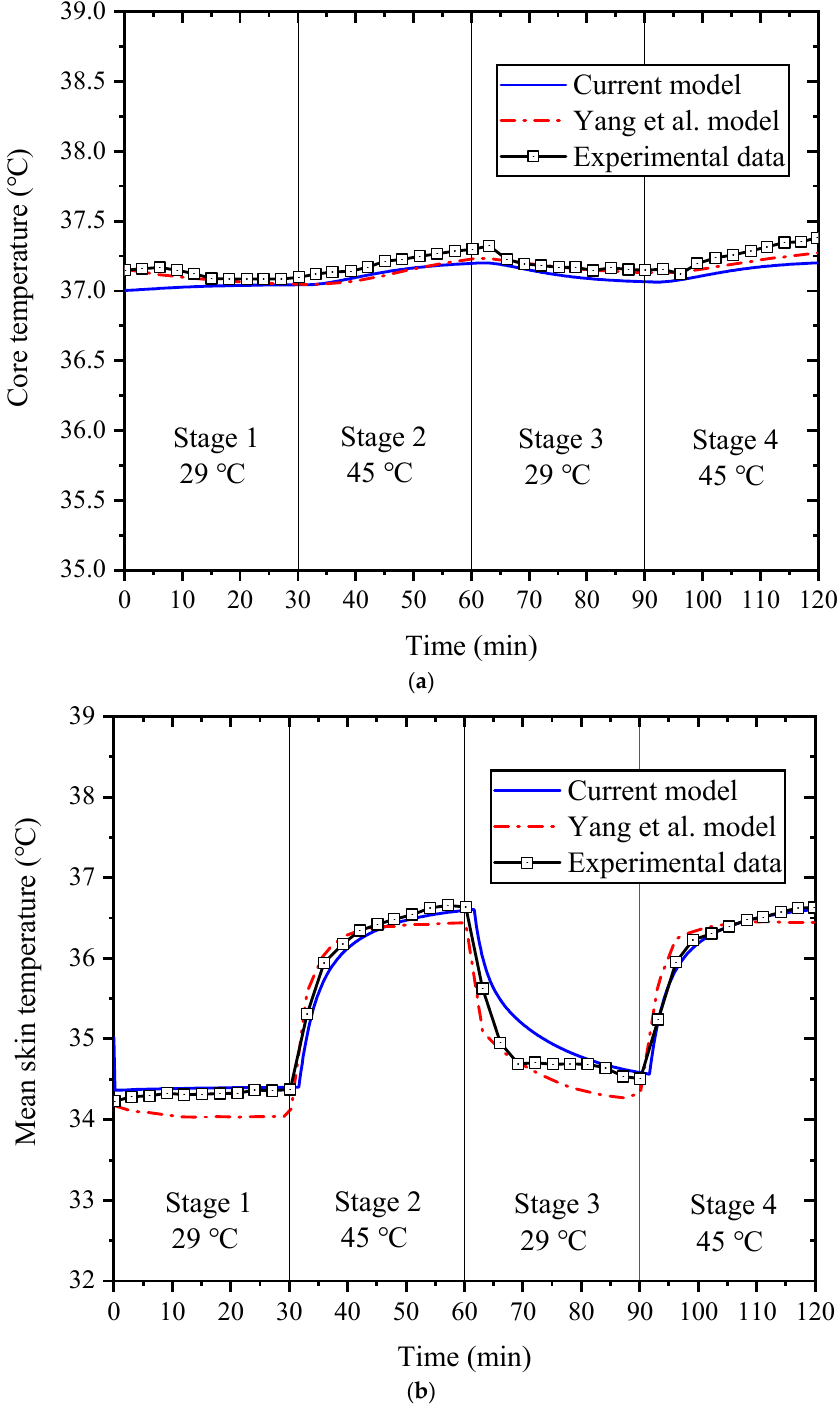
Figure 3. Comparison of core temperature ( a ) and mean skin temperature ( b ) between the experimental data and simulated results of Yang et al. [18] and the simulated results calculated with the current model.